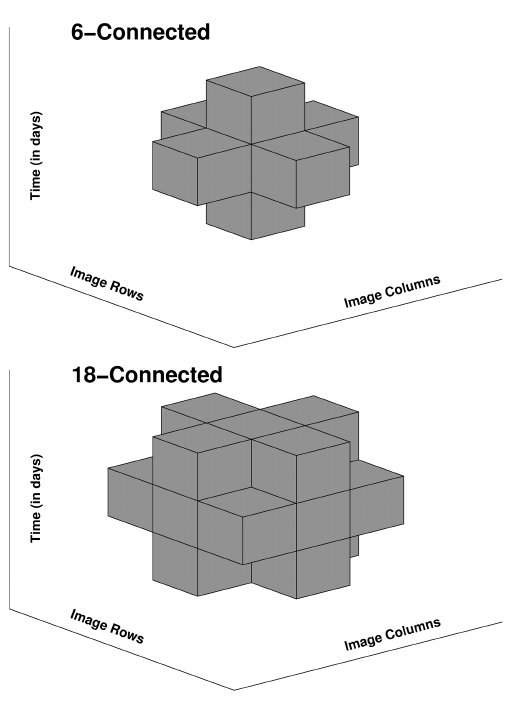
Figure 1. 6- and 18-connected pixel connectivity in 3-dimensional CCL analysis; the axes are image row, image column and day of the